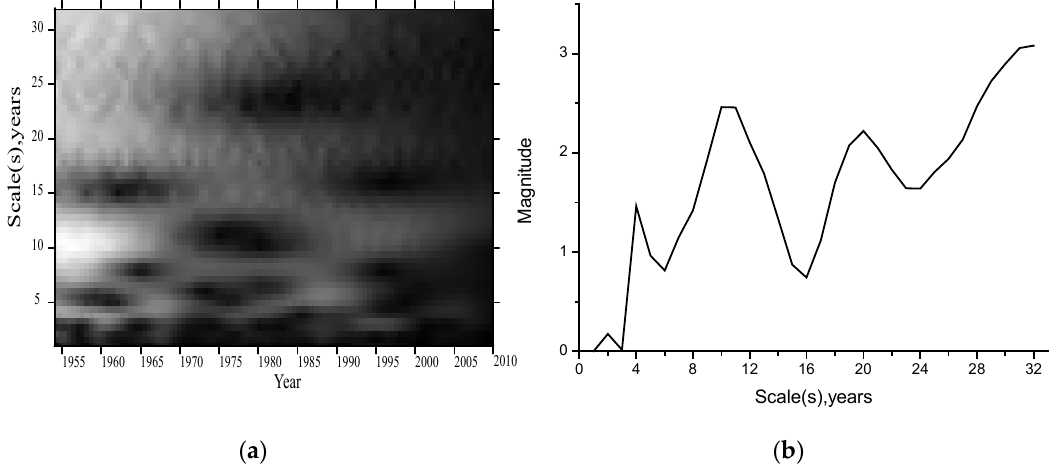
Figure 14. Continuous wavelet spectrum ( a ) and global wavelet spectrum ( b ) of the annual mean streamflow series.